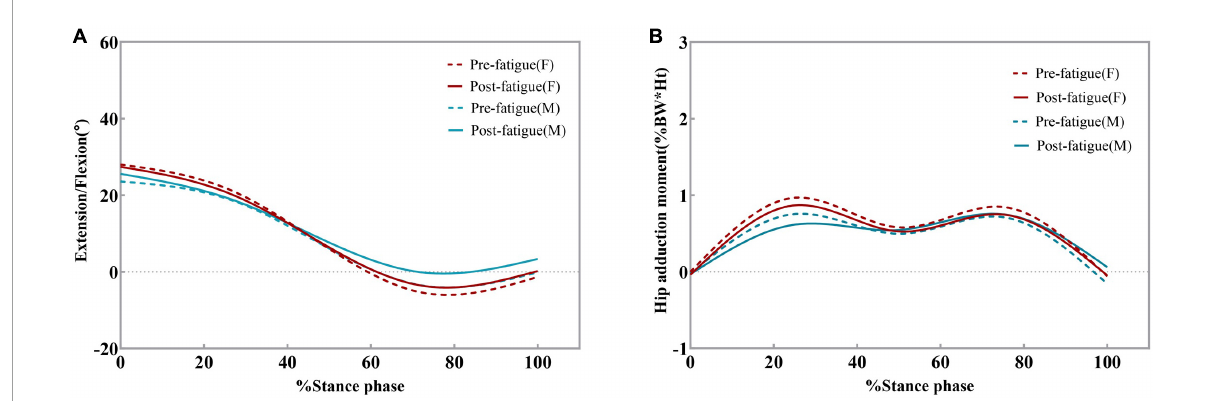
FIGURE5 Ensemble average hip kinematics and kinetics for the dominant limb for all male and female participants. Changes in hip flexion angles (A) and hip adduction moments (B) pre-fatigue and post-fatigue. Moments are given in% bodyweight times height (Ht).